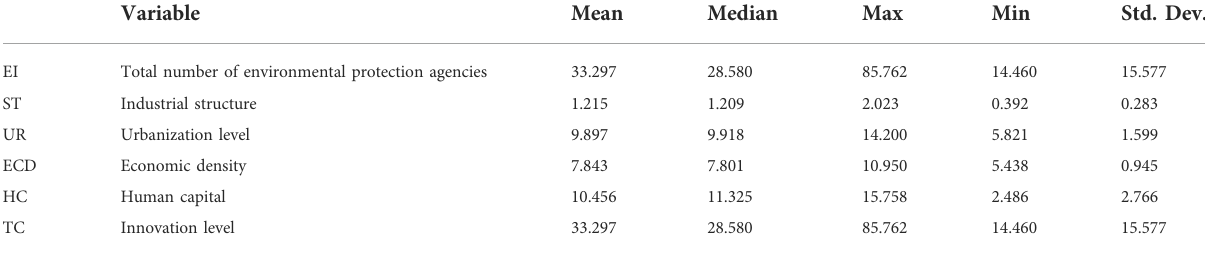
TABLE 2 Statistical descriptions of